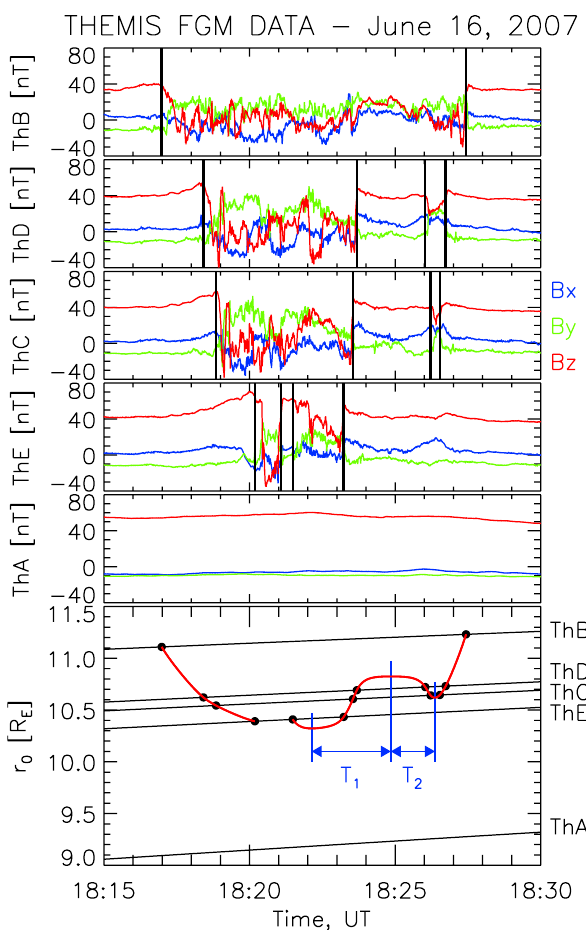
Fig. 1. Top five panels: FGM magnetic field measurements (GSM coordinates) of the five THEMIS spacecraft (ThB, ThD, ThC, ThE and ThA) between 18:15 and 18:30UT on 16 June 2007. Vertical lines depict crossings out of or into the magnetosphere. Bottom panel: diagonal lines show the equivalent standoff distance r 0 of the spacecraft. Dots depict the observed crossings, the red lines show the spline interpolations between crossing times and